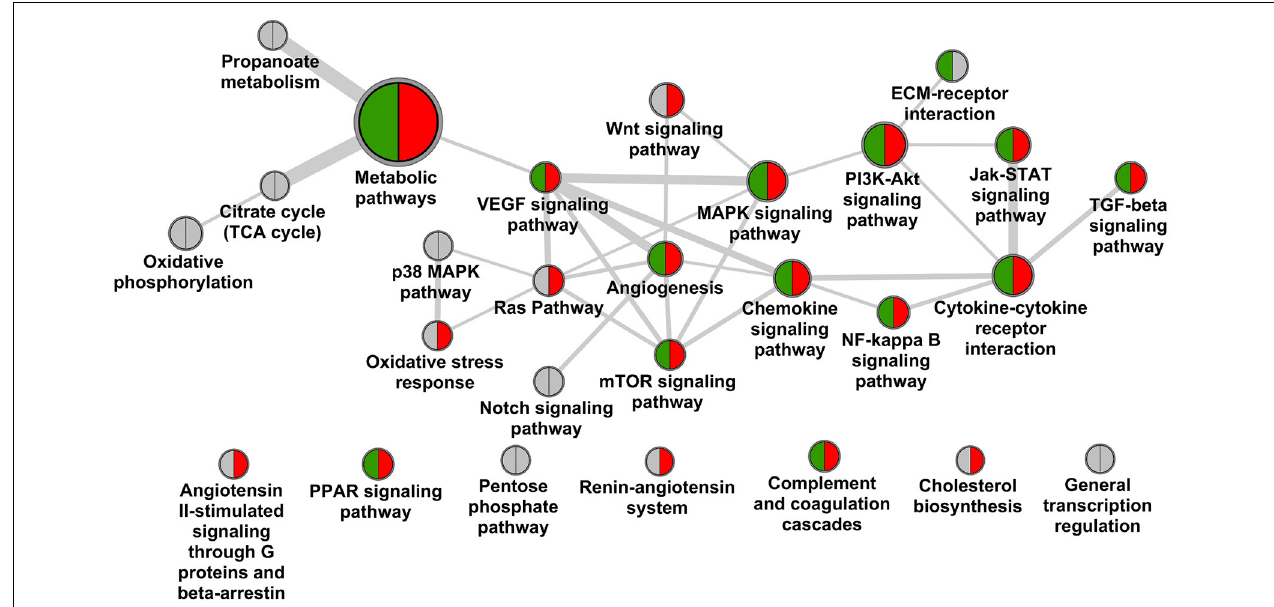
FIGURE 1 | Pathway landscape of diabetic nephropathy. Nodes of the graph represent KEGG and Panther pathways (node diameter scales with number of protein coding genes assigned), edges between nodes scale with